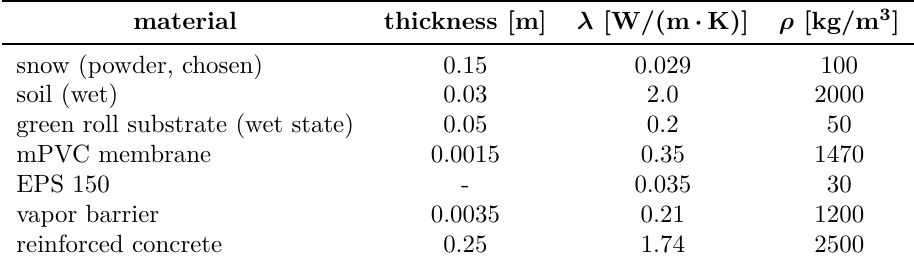
Table 1. Material properties of used materials example [24].